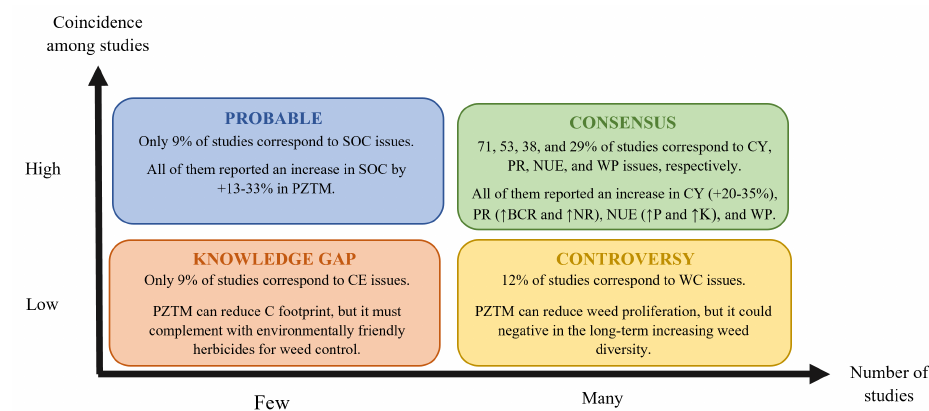
Figure 3. Classification of the evidence level of potato cultivation under zero-tillage and/or organic mulch (PZTM) effects on Saito et al. [22]’s Key Performance Indicator (KPI) as a function of coin- cidence among studies and number of studies [27]. Four or fewer studies are considered as “few”. Analyzed KPIs included: Productivity (CY—crop yield and PR—profitability), resources efficiency (WP—water productivity and NUE—nutrient-use efficiency), soil health (SOC—soil organic carbon), CE—C footprint, and WC—weed control. BCR—benefit–cost ratio. NR—net return. P—phosphorus content. K—potassium content.